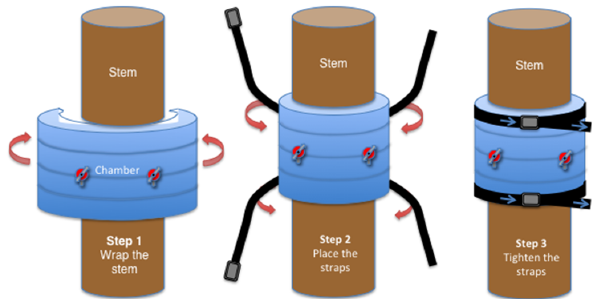
Figure 2. The three steps of the semi-rigid stem sleeve deployment. To ensure a good contact between the frame strips and the stem it was important to distribute the pressure of each strap all around the frames’ periphery when tightening the sleeve. Close to the cen- tre two snap-on rubbers with inserted three-way stopcocks were pressed into the PET or PC plastic sheet. These stopcocks were con- nected to the two PVC tubes that circulated air in a continuous flow mode when connected to an Ultraportable Greenhouse Gas Anal- yser